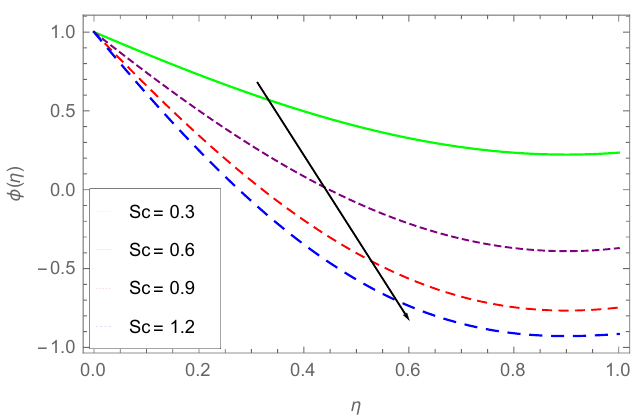
Figure 17. Impact of Sc on φ ( η ) , for Nt = 0.1, Nb = 0.3, β = 0.9, St =